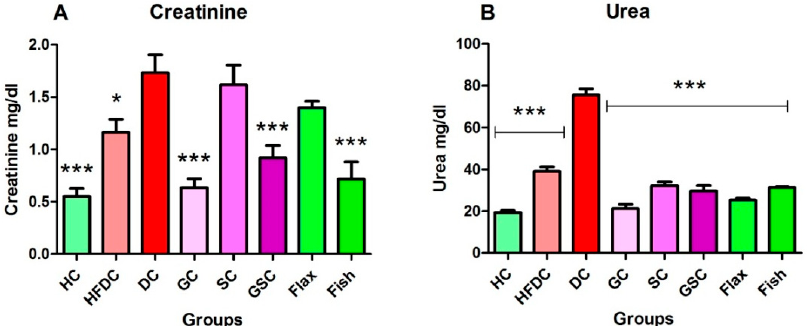
Figure 7. Flax and fish oil interventions improved kidney function. Results are represented as Mean ± SE (n = 6 for each group). * p ≤ 0.05 and *** p ≤ 0.001, when compared with the DC group (Dunnett’s Multiple Comparisons Test). ( A ) Serum creatinine level, ( B ) Serum urea level. HC: Healthy control,